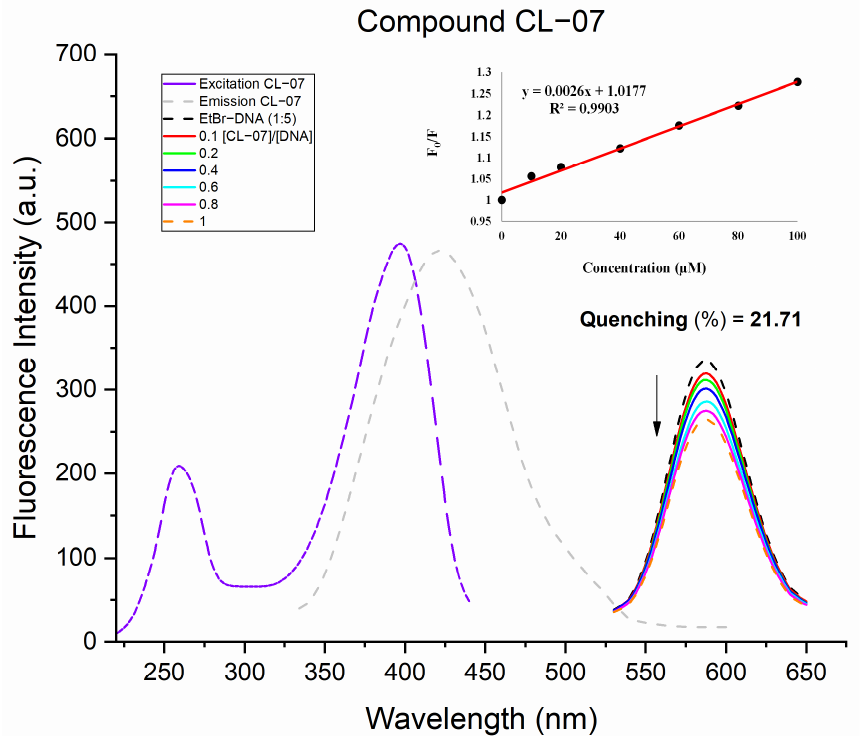
Table 5. Emissive properties of derivatives in the presence of CT DNA–EtBr. Figure 6. Fluorescence quenching spectra of CT DNA–EtBr upon the addition of compound CL − 07. Emission spectrum of CL − 07: excitation at 320 nm with an observation range from 330 to 600 nm. Excitation spectrum of CL − 07: emission at 450 nm and measure range from 440 to 220 nm. Emission quenching curves of EtBr–DNA by CL − 07: [EtBr] = 20 µ mol L − 1 , [DNA] = 100 µ mol L − 1 (ratio 1:5), [CL − 07] = 0–100 µ mol L − 1 ( λ ex = 520 nm).